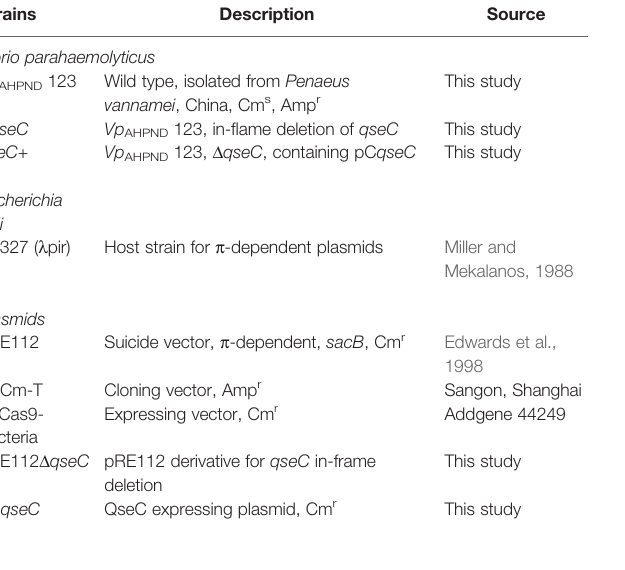
TABLE 1 | Strains and plasmids used in this